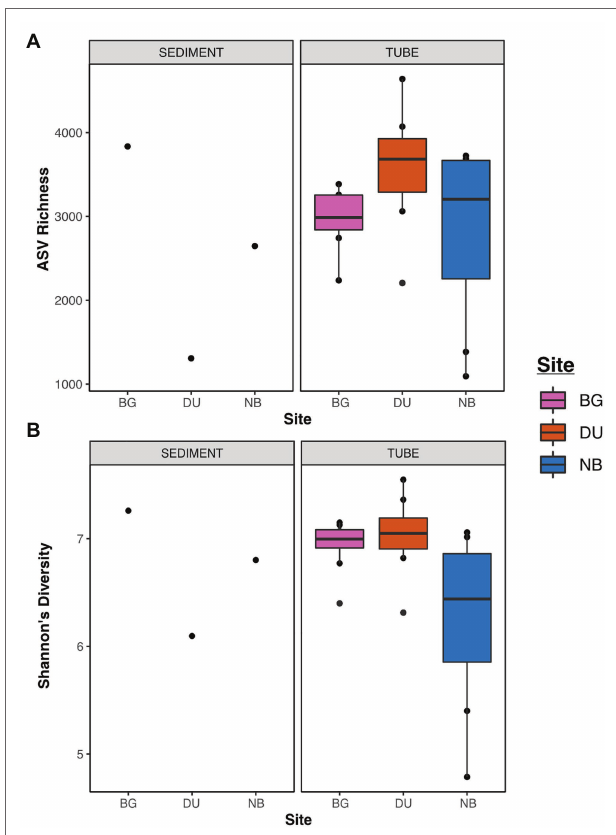
FIGURE 3 | Dot and box-whisker plots of alpha diversities of sediment and tube samples across all three sites [Duke University Marine Lab (DU), Bogue Sound (BG), and North Bridge (NB)] relative to amplicon sequence variant (ASV) richness (A) and Shannon diversity (B)